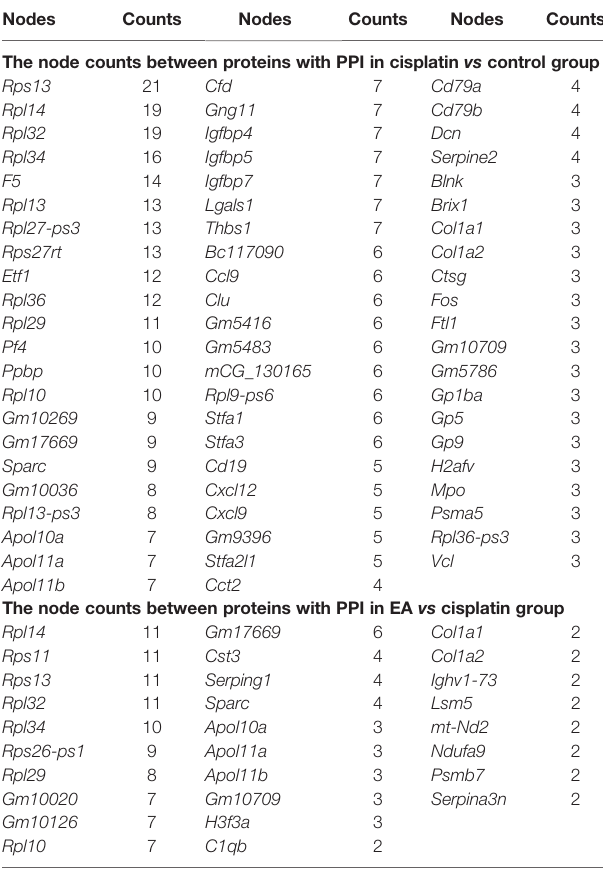
TABLE 2 | The node counts between proteins with PPI. Nodes Counts Nodes Counts Nodes Counts The node counts between proteins with PPI in cisplatin vs control group